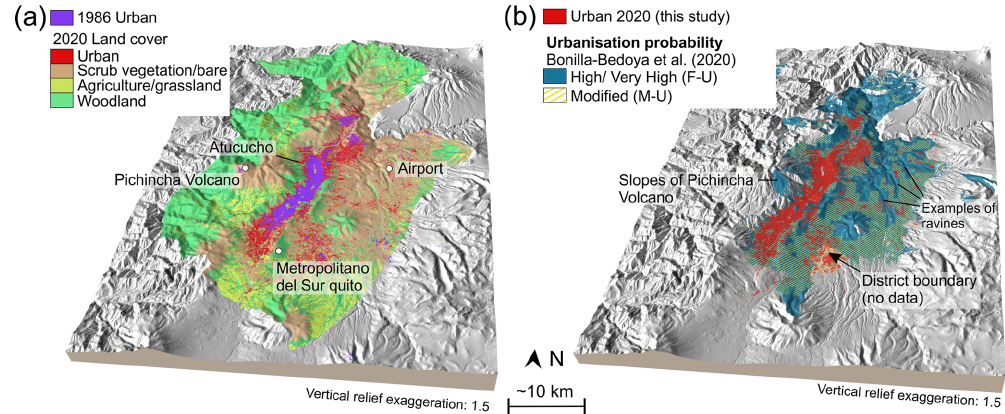
Figure 5. (a) 3D perspective showing urban growth for 1986–2020 and land cover. (b) Quito’s urban area in 2020 compared to modelled future urbanisation (F-U) (Bonilla-Bedoya et al., 2020b) and a modified scenario (M-U). Background is a hillshaded SRTM